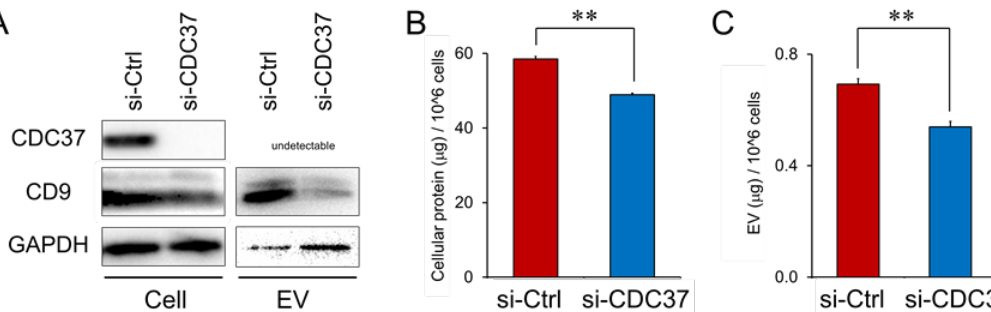
Figure 5. Inhibition of proteostasis and CD9 in EVs by the knockdown of CDC37. The siRNA targeting CDC37 or non-targeting control siRNA was transfected into PC-3 cells. Cell lysate and EVs were prepared at 48 h after the transfection. ( A ) Western blot showing CDC37, CD9, and GAPDH in PC-3 cells. EVs were prepared using 200-nm pore filter devices and PBP method. ( B ) Cellular protein concentration per million cells. ** p < 0.01, n = 3. ( C ) EV protein concentration per million cells. ** p < 0.01, n =